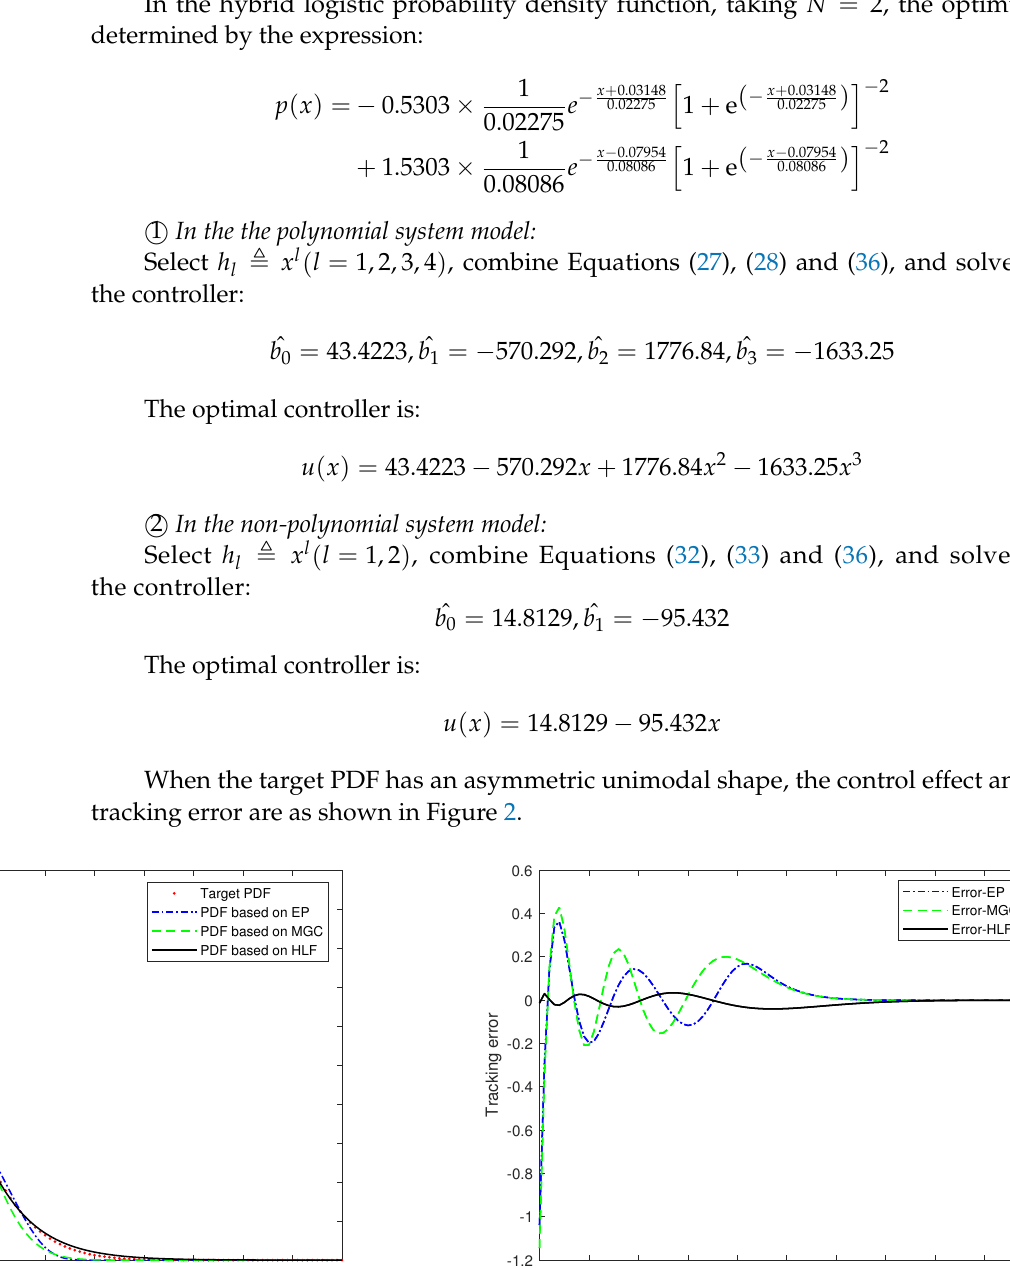
We take N = 4 in the hybrid logistic probability density function and obtain the optimal solution